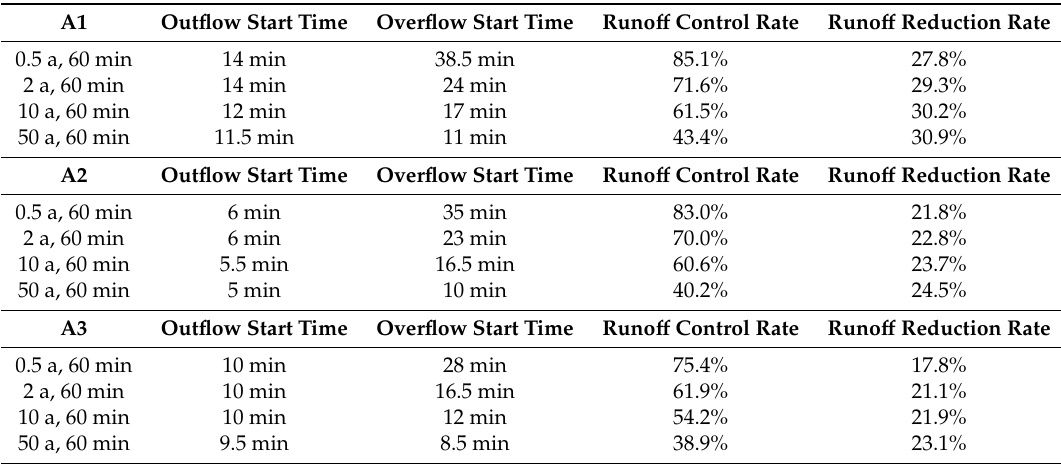
Table 2. Runo ff control e ff ects of each bioretention units under di ff erent rainfall